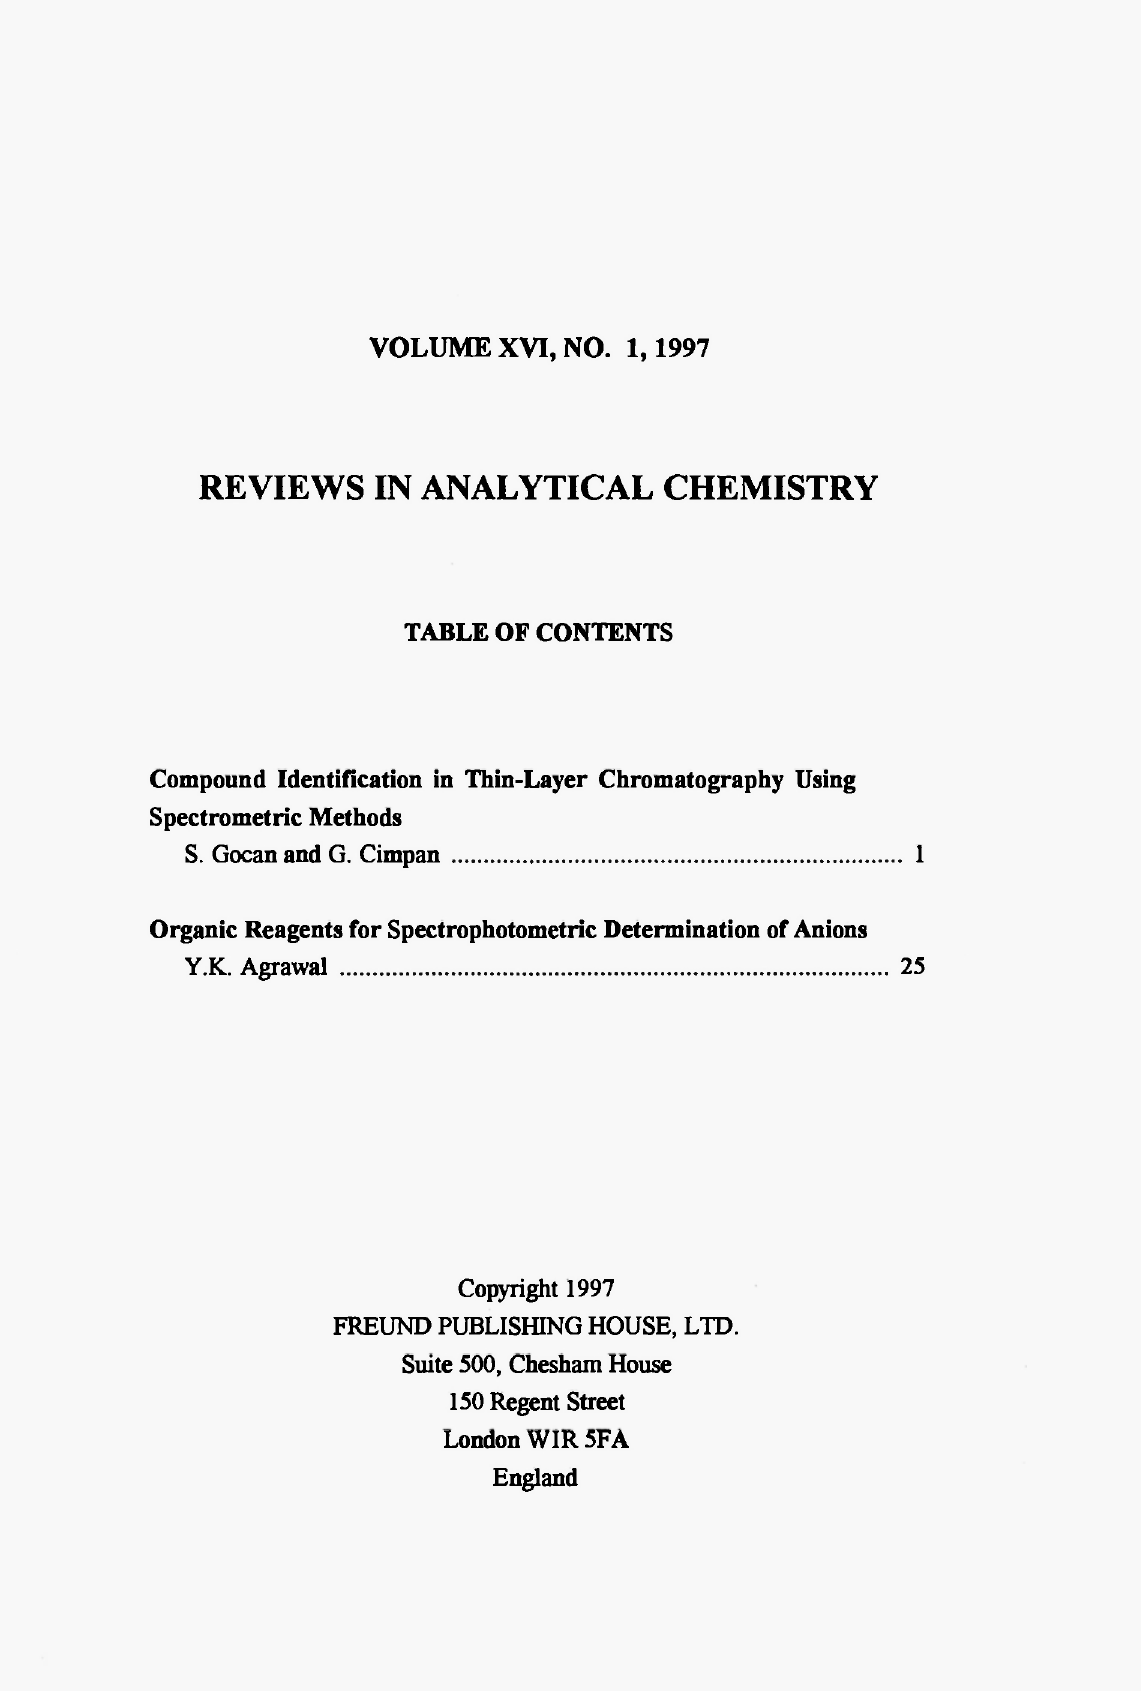
Compound Identification in Thin-Layer Chromatography Using Spectrometric Methods